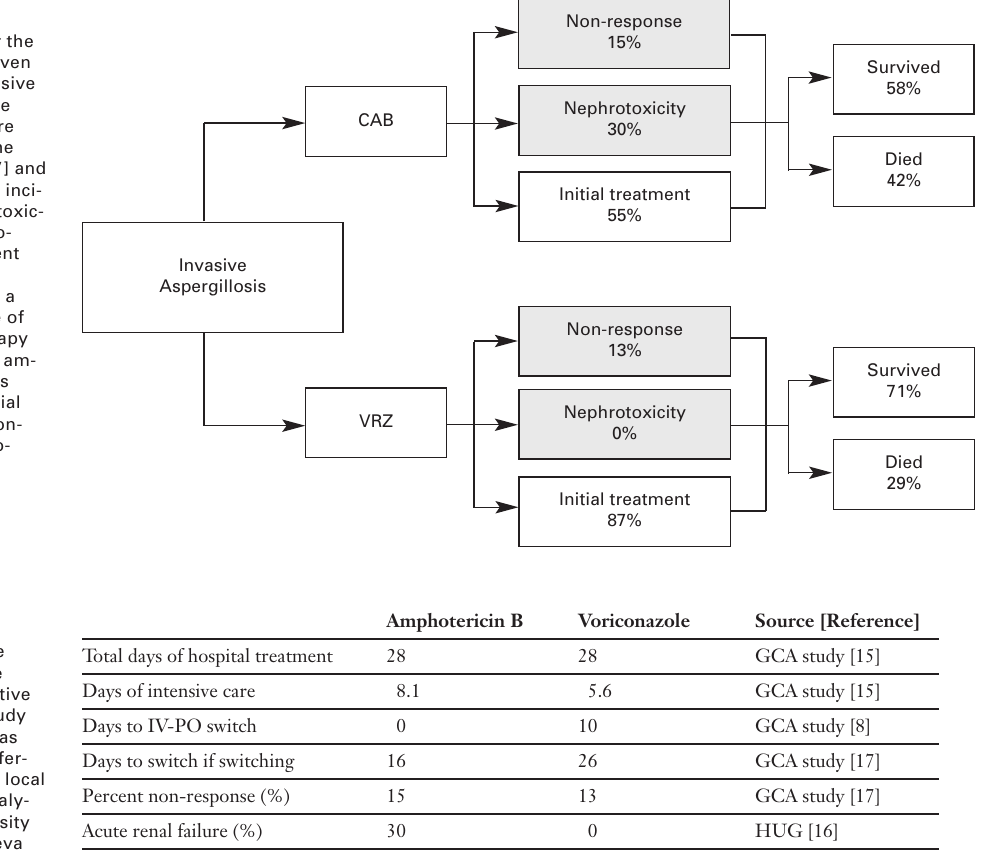
Table 1 Model inputs are derived from the Global Comparative Aspergillosis Study database (GCA) as published by